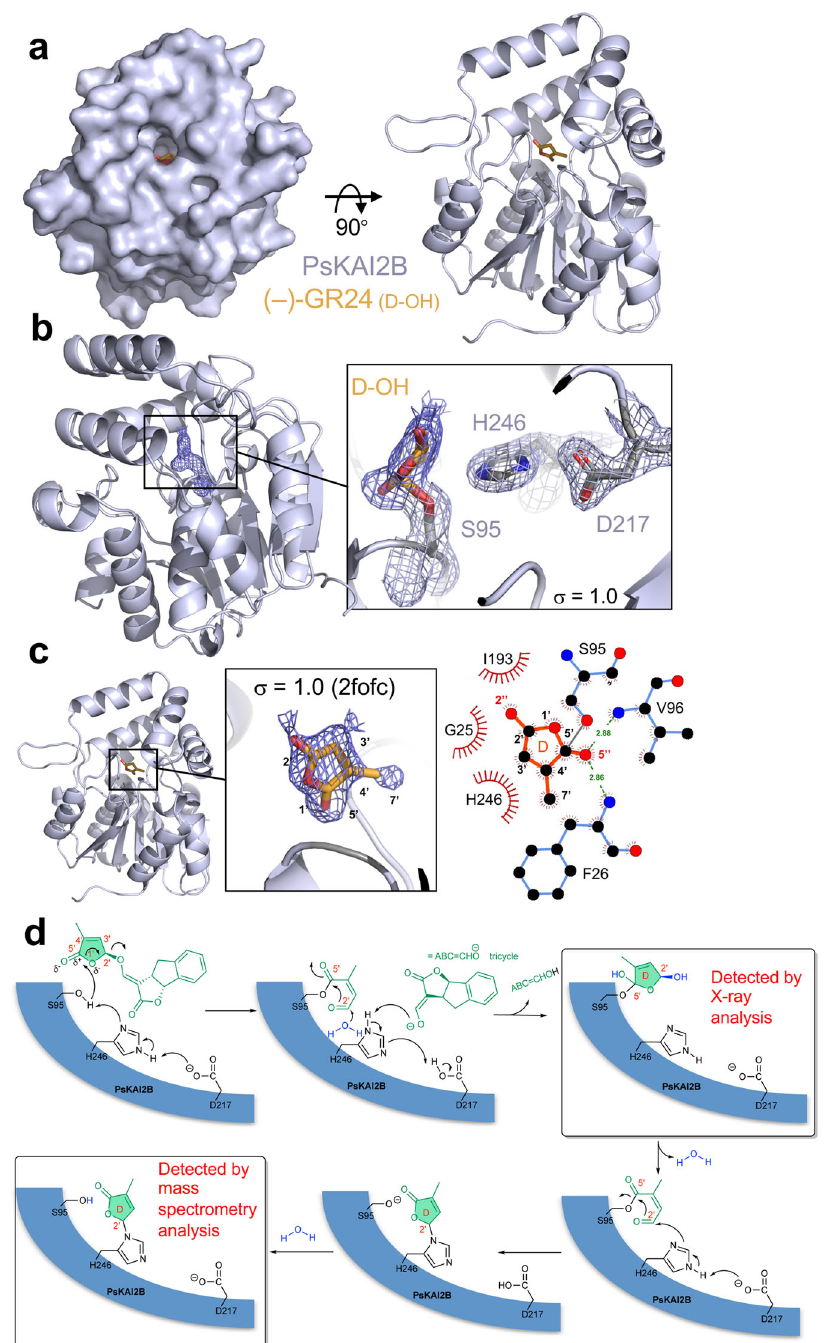
Fig. 8 Structural basis of PsKAI2B ligand interaction. a Surface (left) and cartoon (right) representations of PsKAI2B crystal structure in complex with ( – )-GR24 D-OH ring. Protein structure is shown in blue/gray and ligand in orange. b Close-up view on ligand interactions and contiguous density with the catalytic serine S95. Electron density for the ligand is shown in navy blue and blue/gray mesh for the labeled catalytic triad. The contiguous density between S95 and the D-OH ring indicates a covalent bond. The electron density is derived from 2mFoDFc (2fofc) map contoured at 1.0 s. c Side view of PsKAI2B-D-OH structure shown in cartoon with highlighted (orange) the intact D-OH ring structure. 2-D ligand interaction plot was generated using LigPlot + software. Dark gray line represents S95-D-OH ring covalent bond. d Schematic diagram of the proposed mechanism for the formation of the D-ring intermediate covalently bound to S95 in a fi rst time and then to